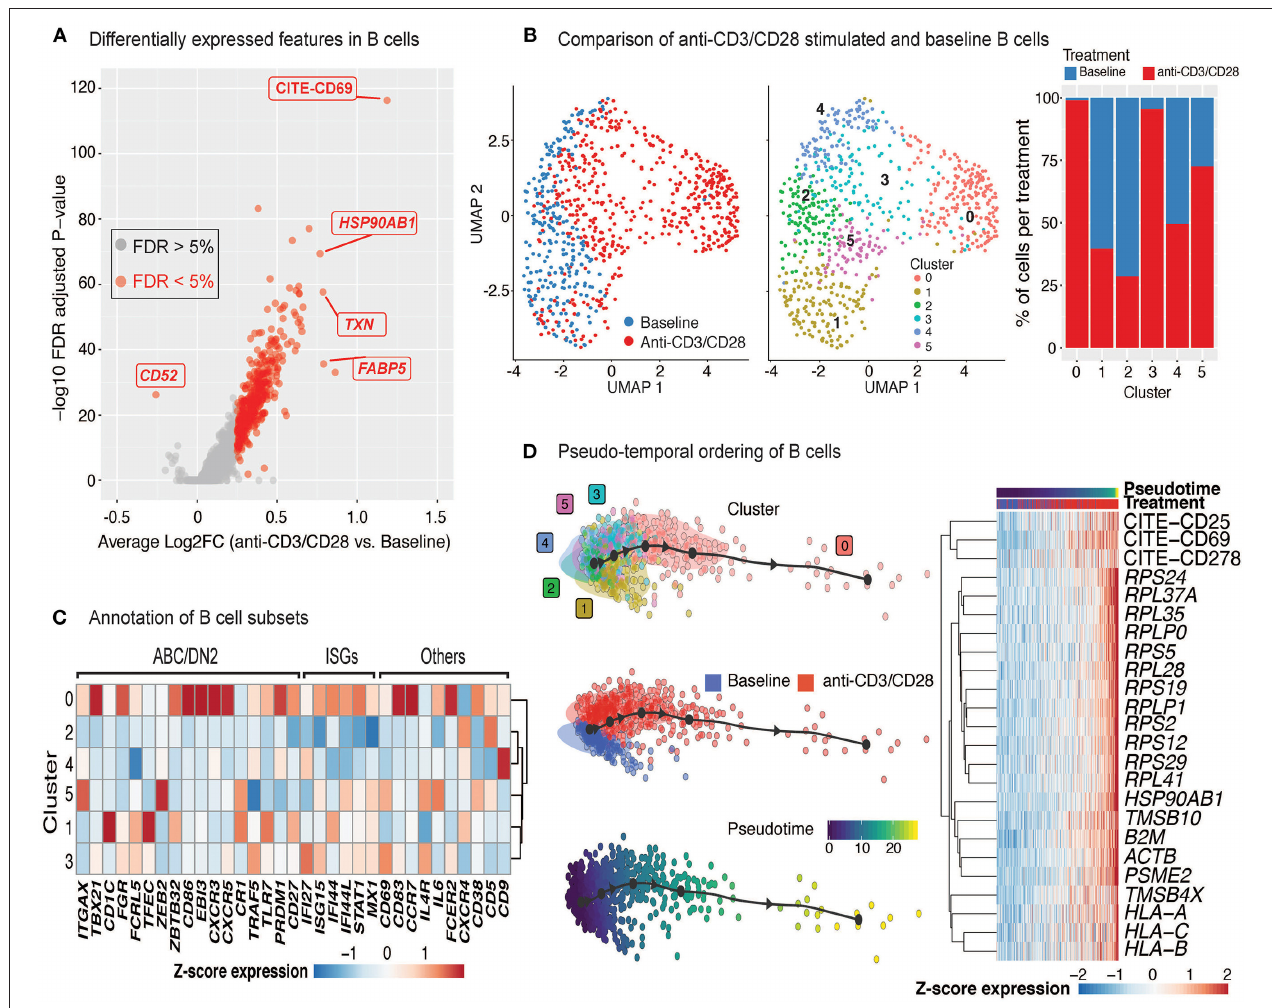
FIGURE 5 | Indirect activation of B cells. (A) Volcano plot summarizing the genes induced in anti-CD3/CD28-activated B cells relative to those at baseline. (B) Analysis of B cells at baseline and after anti-CD3/CD28 stimulation revealed six subgroups (middle). Primarily, anti-CD3/CD28-stimulated B cells clustered separately from those at baseline (left). Distribution of B cells in each cluster across the two conditions (right). Activated B cells were mostly in clusters 0 and 3. (C) Heatmap of age-associated B cell (ABC)/double negative 2 (DN2), interferon stimulated genes (ISGs), and other genes used to annotate the distinct B cell subpopulations. Values in each heatmap represent average scaled gene expression of all cells in the corresponding cluster. (D) (left) Pseudotime trajectory inference of B cells at baseline and anti-CD3/CD28 conditions. (right) Genes and proteins with temporal patterns of expression in pseudo-temporal ordered B